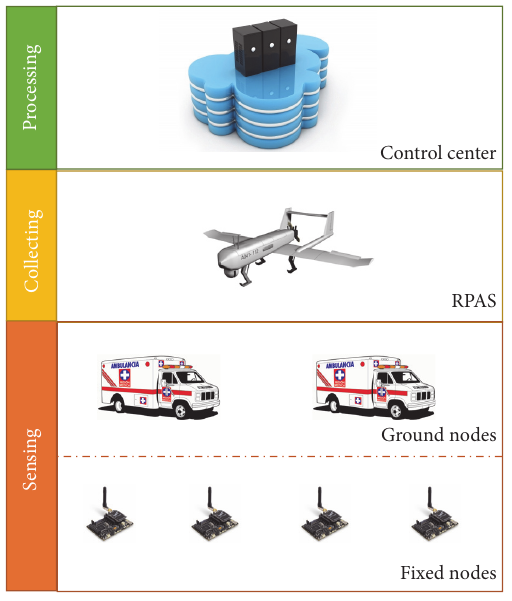
Figure 1: Three-layer